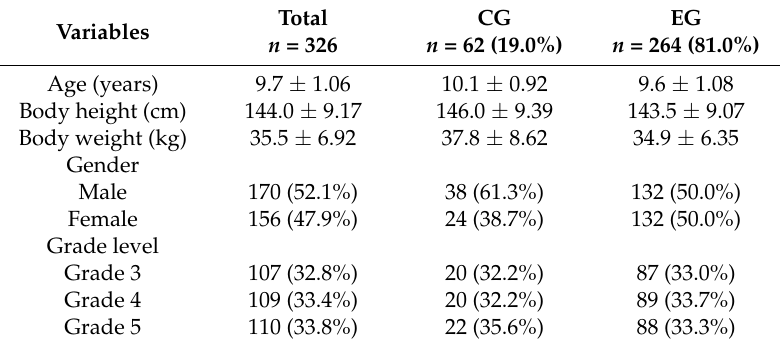
Table 1. General characteristics (mean, standard deviation and frequency) of the